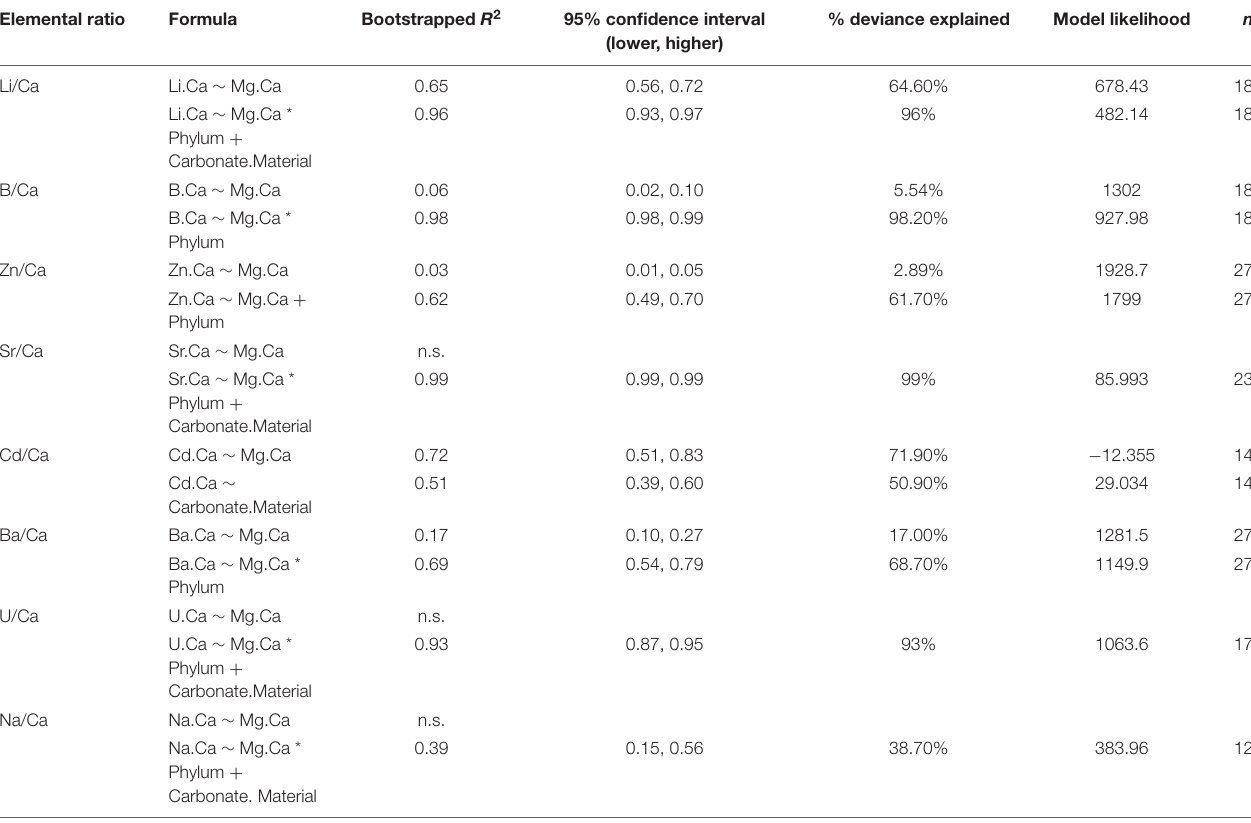
TABLE 6 | Summary of the simplest (X/Ca vs. Mg/Ca) as well as the final GAMs (bolded) as determined by likelihood ratio tests results for the X/Ca vs. Mg/Ca scatterplots ( Figure 2 ). Elemental